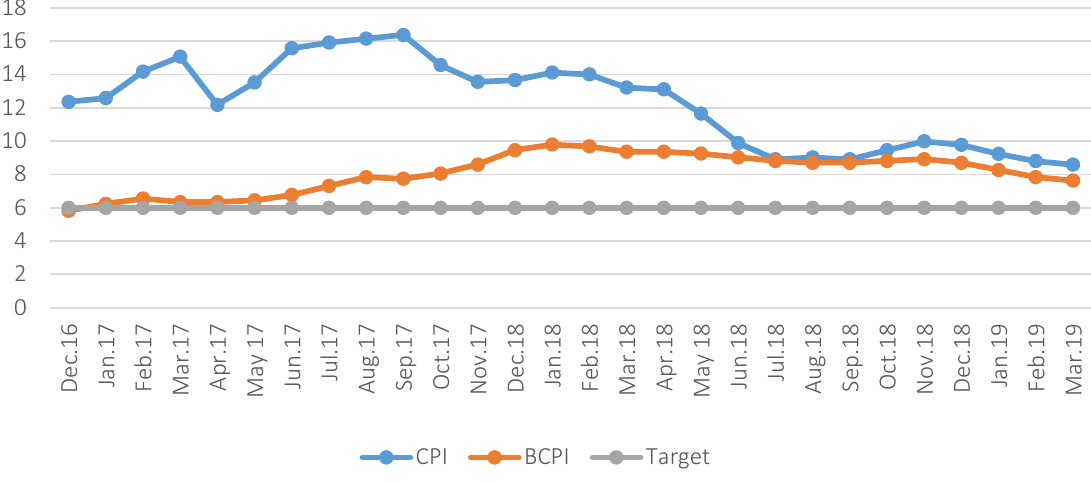
Figure 6. Annual consumer and basic inflation